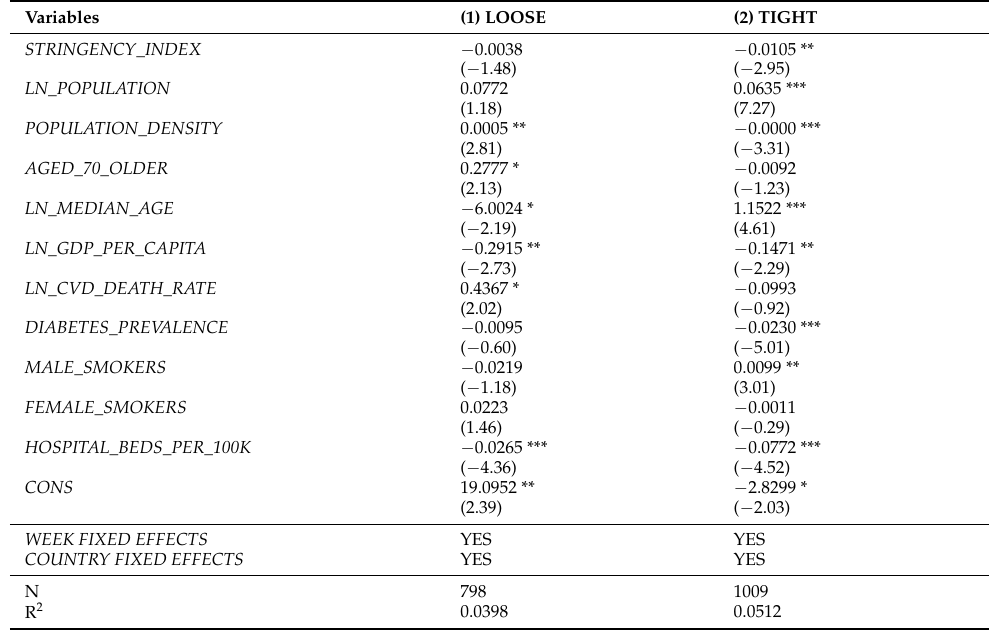
Table 4. Regression analysis of the effect of cultural tightness–looseness on the correlation between government responses and the COVID-19